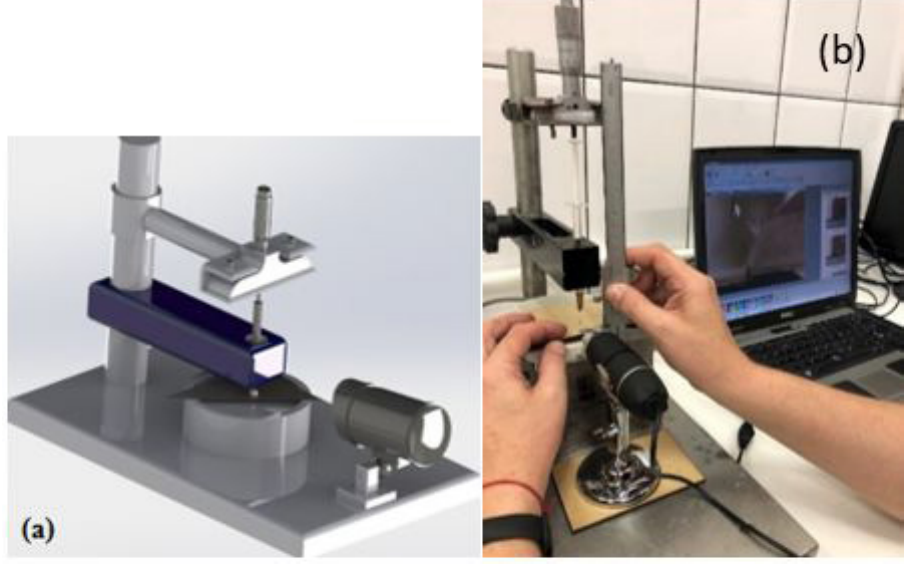
Figure 4. (a) 3D project of the measuring apparatus (b) Measuring apparatus in the Pronto Laboratory